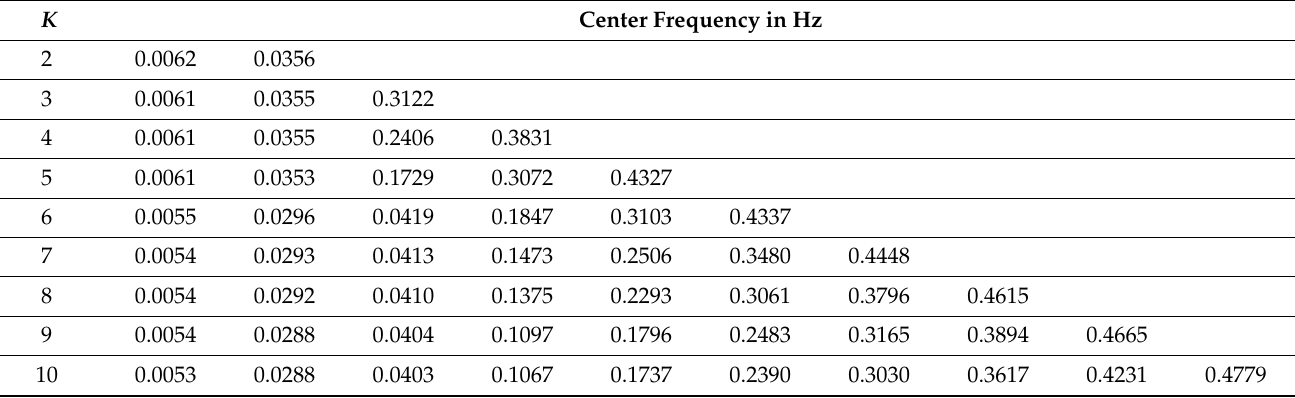
Table 4. The central frequency at different values of K